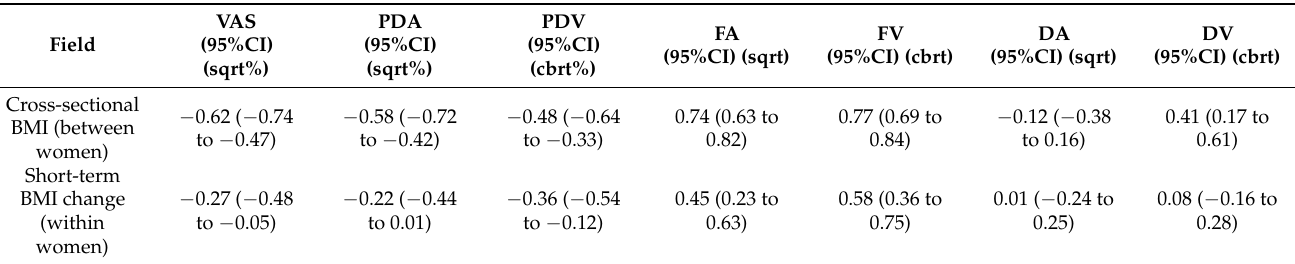
Table 2. Repeated measures between women and within women correlations for mammographic density and body mass index.